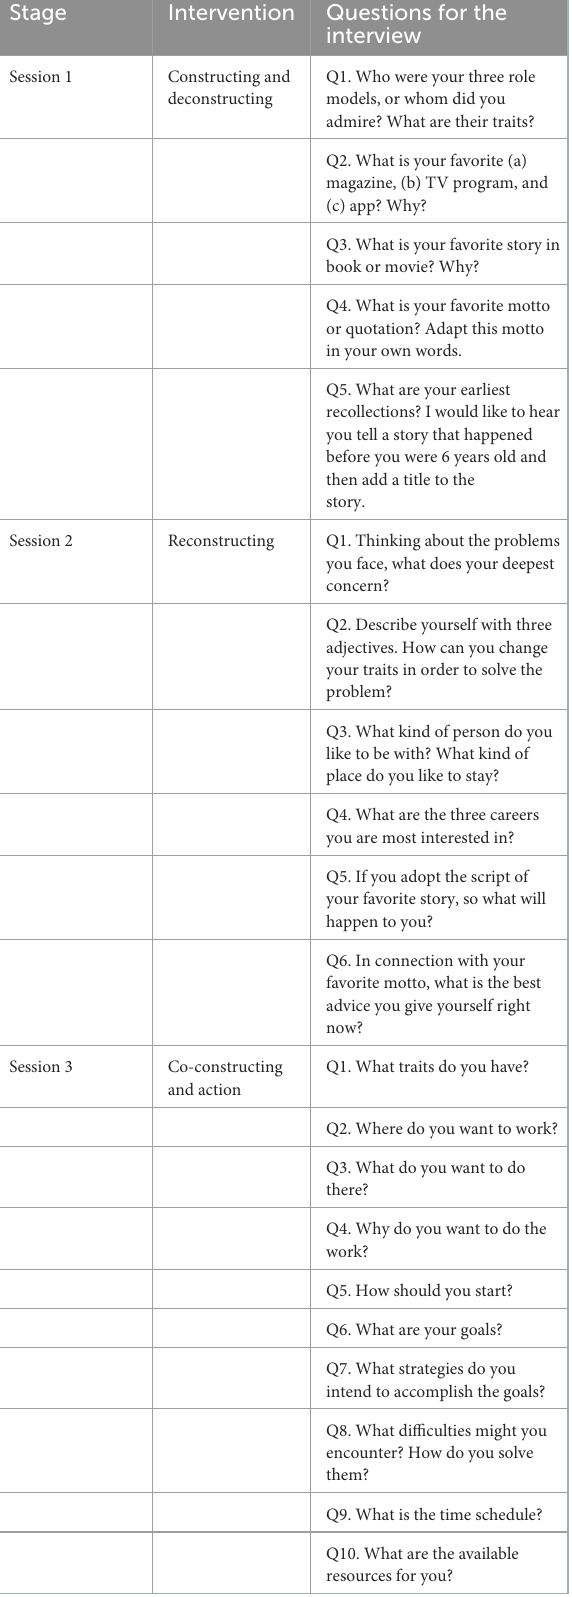
TABLE 2 Life design counseling